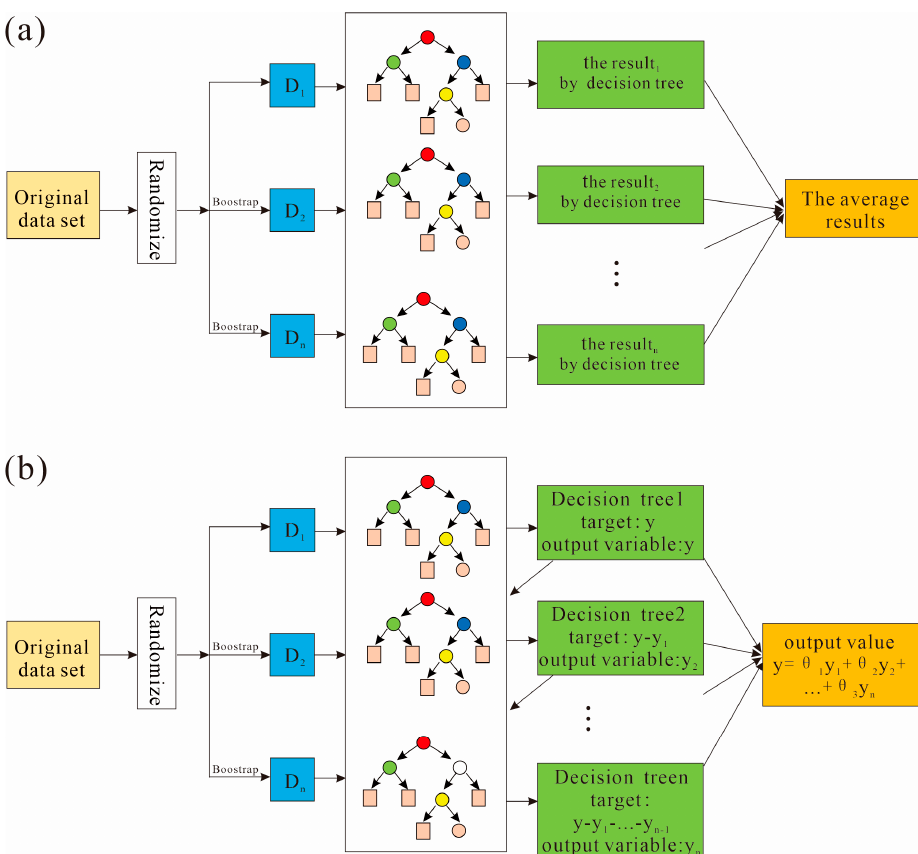
Figure 1. Principles of RF and GBDT algorithms: ( a ) RF model;( b ) GBDT model.